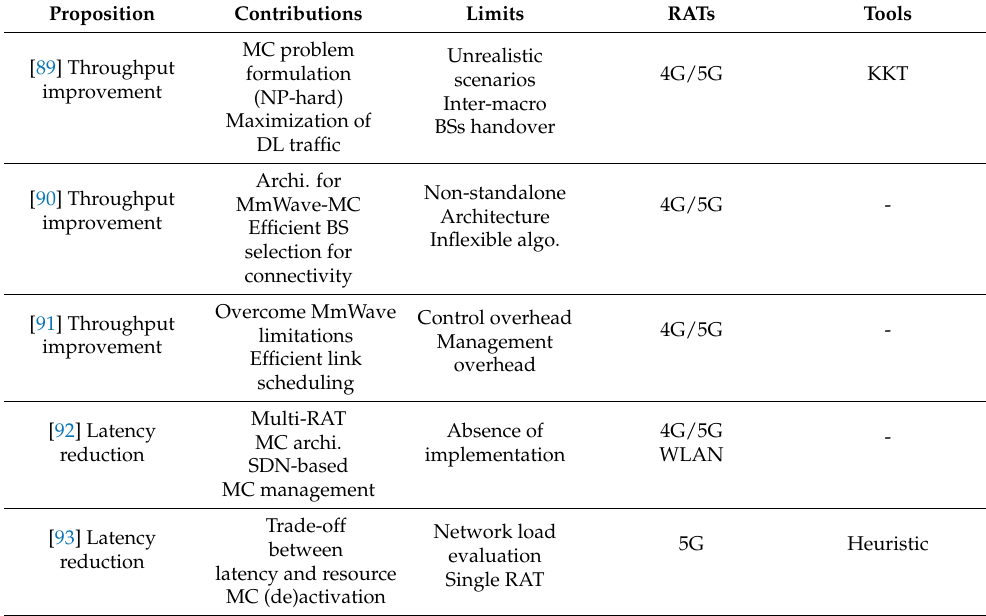
Table 3. Comparison of existing solutions to improve